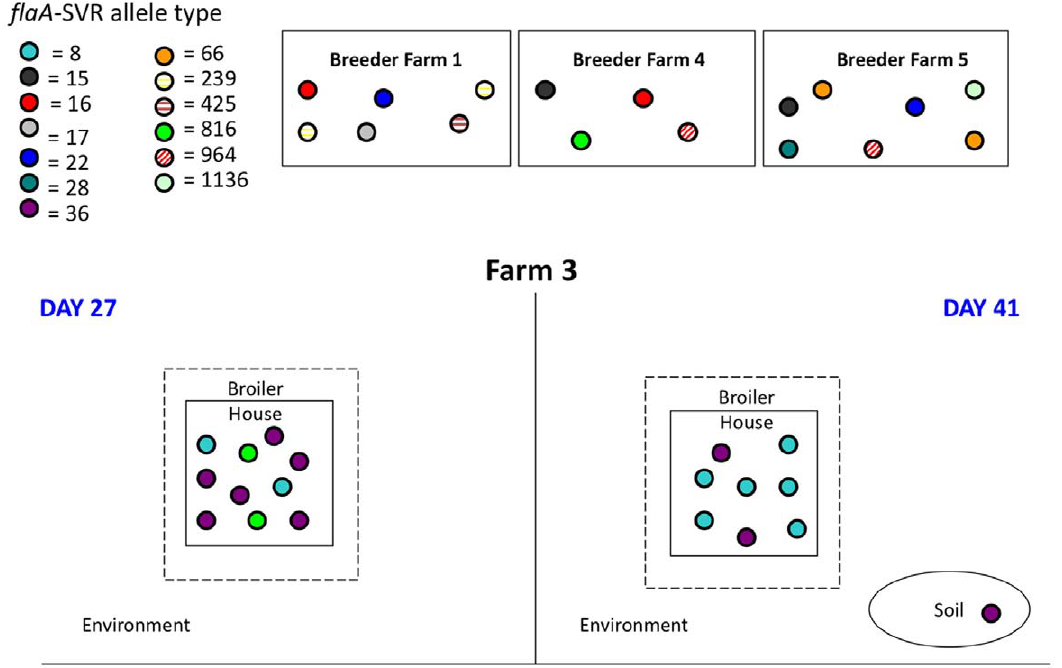
Figure 4. Schematic diagram of the flaA -SVR alleles detected on farm 3.